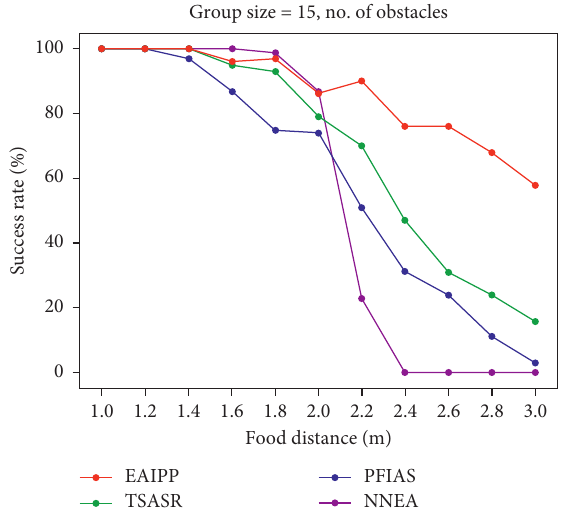
Figure 12: Effect of task difficulty on the success rate for a group size of N � 15.